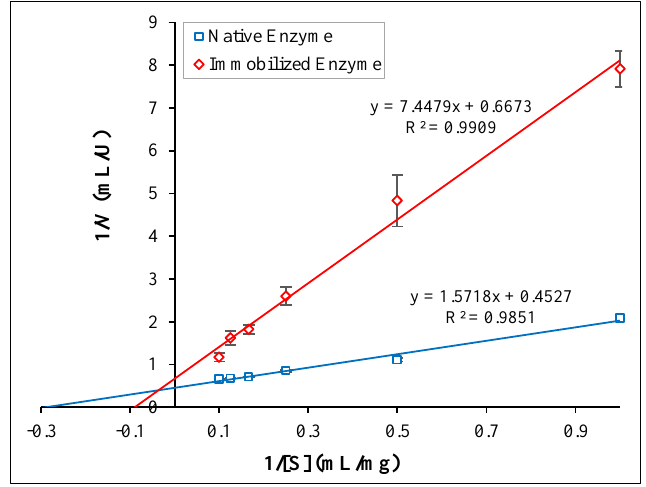
Figure 5. Lineweaver-Burk plot of the native and immobilized enzymes (mean ± SD; n = 2; p < 0.05) Table 2. Kinetic parameters for the native and immobilized α-amylase in the latest